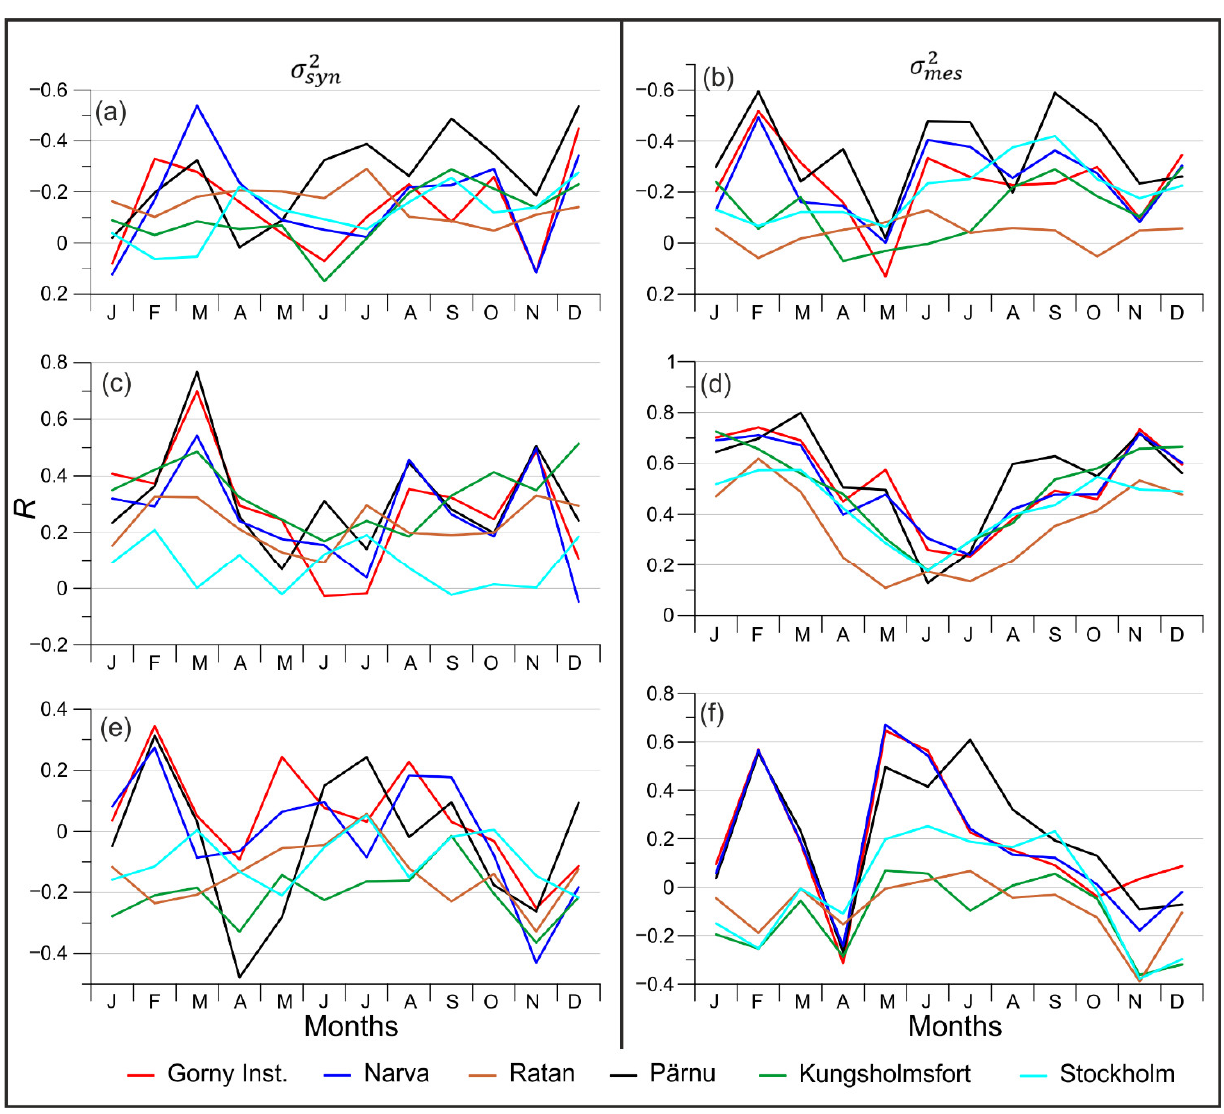
Figure 5. Correlation coefficient (R) of the variance of ( a , c , e ) synoptic and ( b , d , f ) mesoscale sea level oscillations and monthly mean values of ( a , b ) surface atmospheric pressure, ( c , d ) zonal, and ( e , f ) meridional winds in different months.